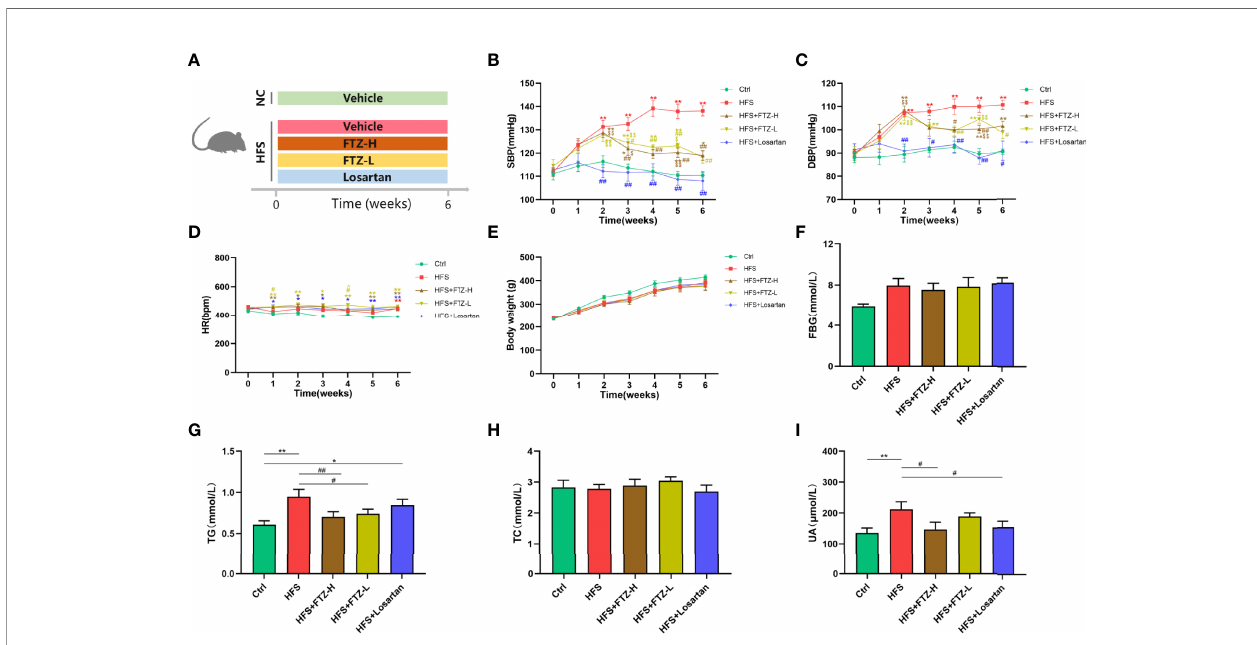
FIGURE 1 | FTZ inhibited blood pressure elevation and improved lipid and uric acid metabolism in HFS-fed rats. (A) A schematic diagram for Experiment 1. (B) Systolic blood pressure. (C) Diastolic blood pressure. (D) Heart rate. (E) Body weight. (F) Fasting blood glucose. (G – I) Serum TG, TC, and UA. ∗ p < 0.05, ∗∗ p < 0.01 vs. Ctrl; # p < 0.05, ## p < 0.01 vs. HFS $ p < 0.05, $$ p < 0.01 vs. HFS+Losartan. n = 8 per group. FTZ, Fufang-Zhenzhu-Tiaozhi capsule; HFS, high fructose and high salt; TG, triglyceride; TC, total cholesterol; UA, uric